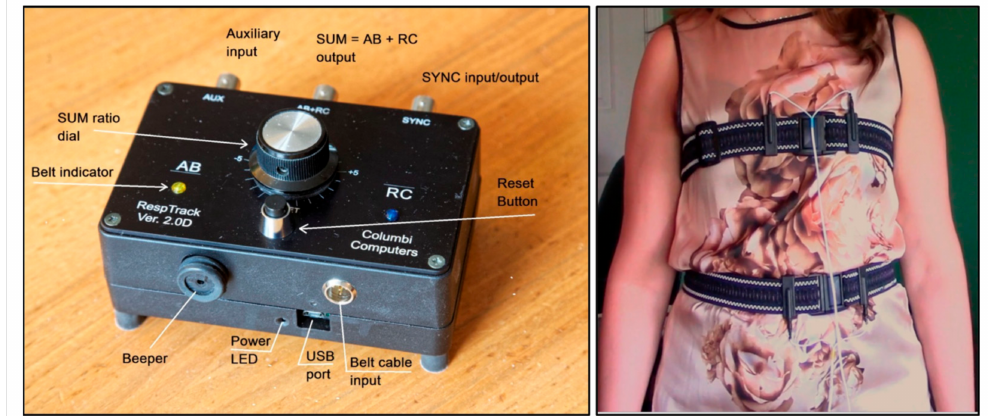
Figure 2. ( Left ) RespTrack unit; ( Right ) placement of belts monitoring ribcage and abdominal wall